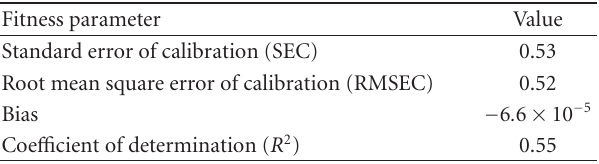
Table 1: Fitness measures of MLR model on calibration group of in-shell peanuts.